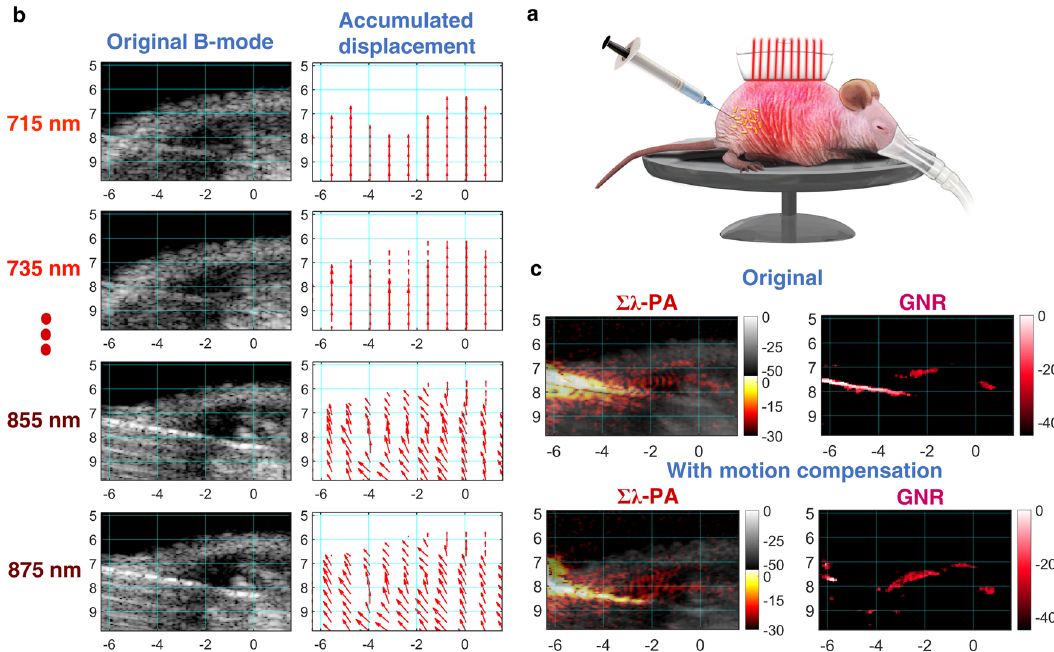
Fig. 5 Case #1 of in vivo spectroscopic imaging for GNR injection into a mouse right leg muscle. Effects of motion artifacts on quantitative PA measurements are illustrated. a Experimental setup. b Inter-wavelength motion artifacts during nanoparticle injection (See movements in B-mode images with wavelength). Inter-wavelength motion vector is estimated from two successive B-mode images using PatchMatch-based speckle tracking, and then accumulated over each wavelength sequence to produce the fi nal motion-corrected PA images. For easy visualization, vectors are spatially decimated. c The original uncompensated wavelength-compounded Σλ -PAUS (left) and corresponding GNR-weighted PA (right) images. Motion artifacts corrupt GNR- weighted PA images as the needle is not rejected. d The needle is completely rejected in GNR-weighted PA images and GNR detectability is also improved in motion-corrected